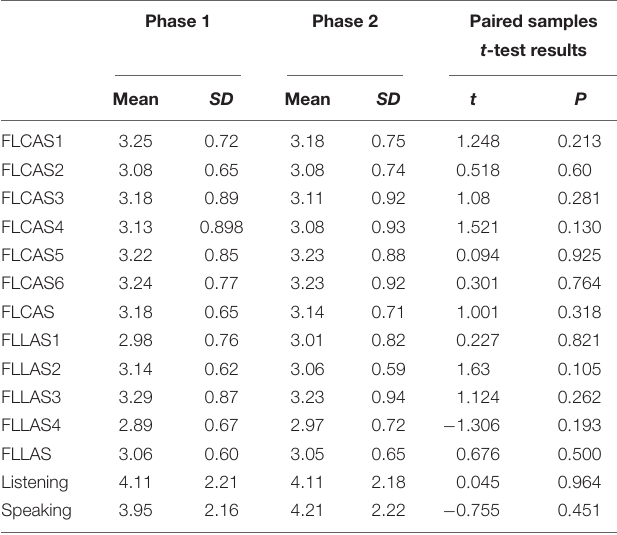
TABLE 2 | Means, standard deviations, and paired samples t -test results of FLCAS and FLLAS scales in both phases ( N = 182). Phase 1 Phase 2 Paired samples t -test